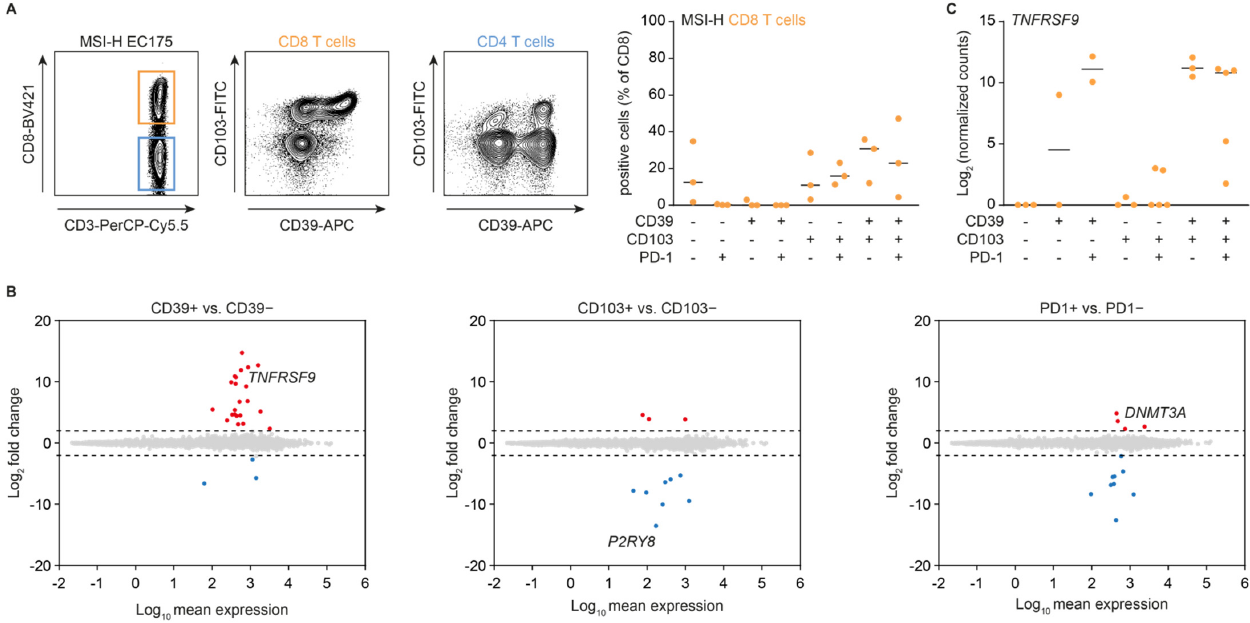
Figure 1. Gene expression is independently associated with CD103, CD39, or PD-1 expression. ( A ) Representative and quantified cell surface expression of CD103 and CD39 on CD8+ T cells, as determined by flow cytometry for tumor-infiltrating T cells from 3 independent MSI-H endometrial cancer patients. ( B ) Differential gene expression between positive and negative CD39 (left), CD103 (middle), and PD-1 (right) tumor-infiltrating CD8+ T cells as determined by mRNA sequencing. Genes with a Benjamini-Hochberg FDR < 0.1 were selected as significantly changed. ( C ) Log2- normalized gene expression counts for TNFRSF9 in the indicated cell subsets as determined by mRNA sequencing ( n = 3 patients; >2 technical replicates per